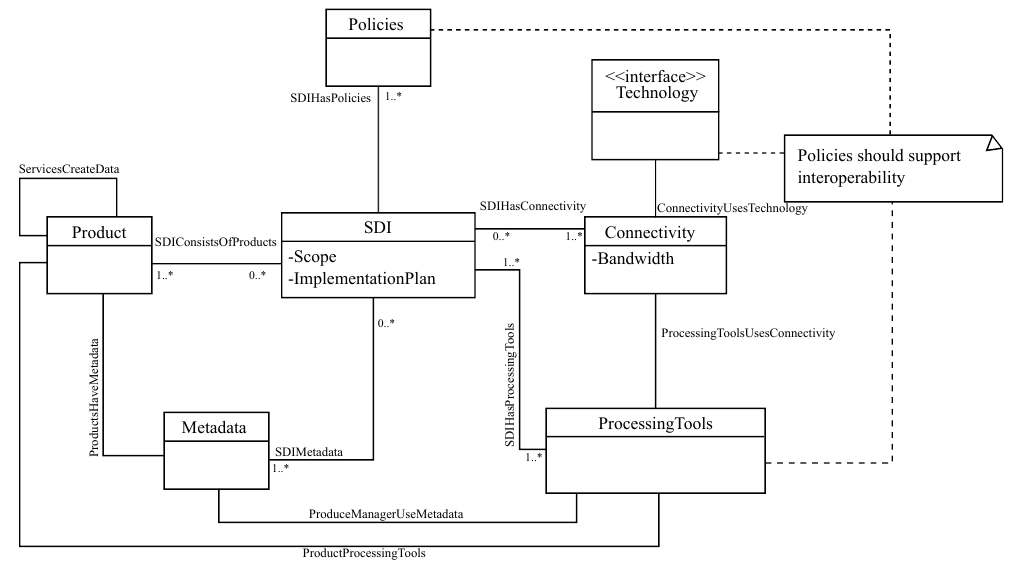
Figure 8. Class diagram for the Enterprise viewpoint. Source: